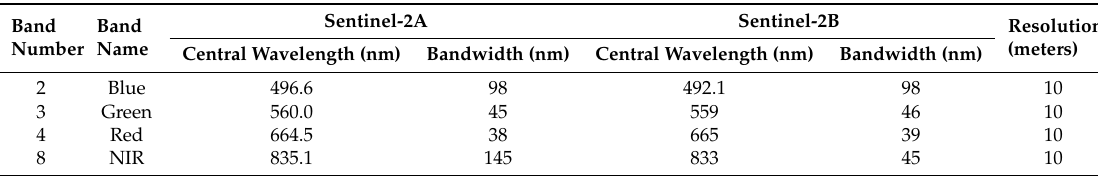
Table 2. The Sentinel-2 spectral bands considered in the